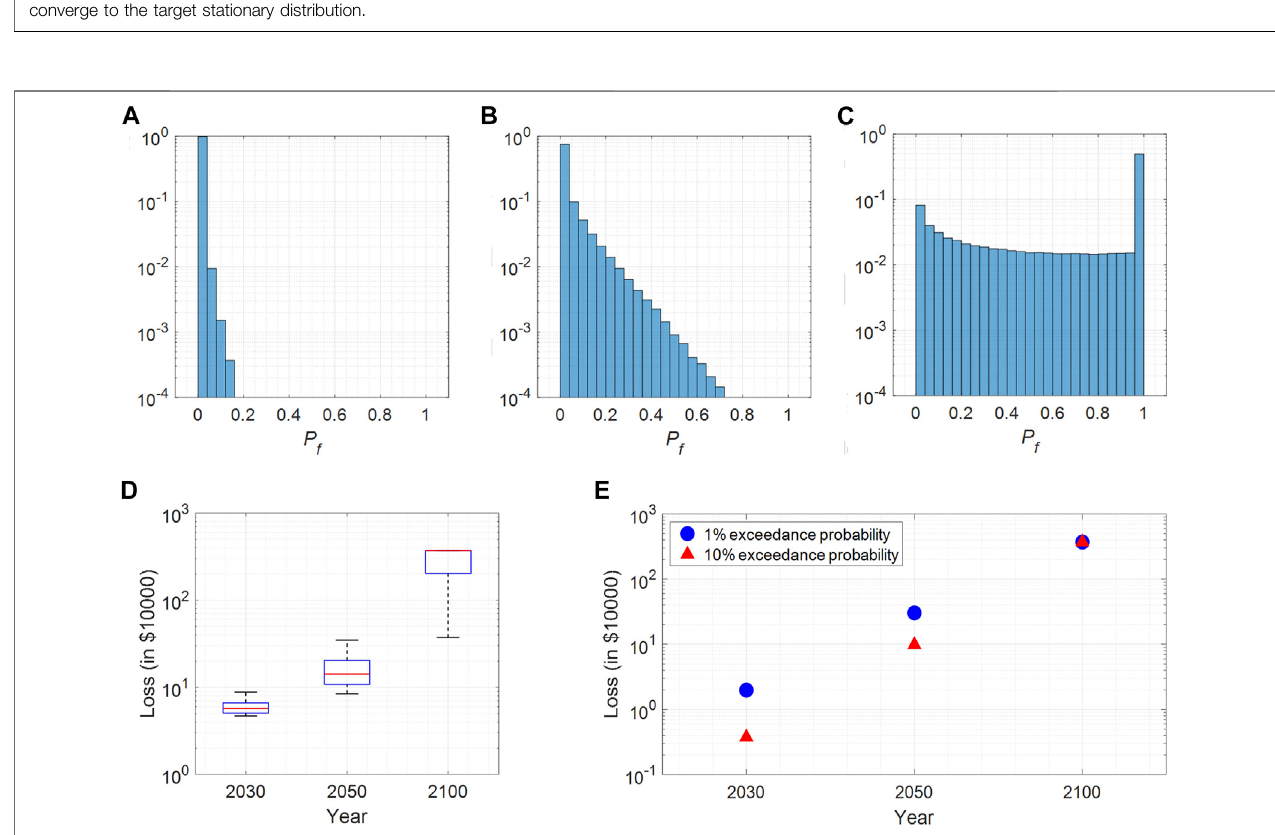
FIGURE 5| (A) The normalized histogram of failure probability of the house in the year 2030, (B) 2050, and (C) 2100, (D) the boxplot of the conditional distribution ofloss giventhe probability offailure ismore than 10%. Theblue box limits the25 and 75percentile loss,the red linedenotes themedian loss,and the twoend whiskers denote 5 and 95 percentile loss (E) the marginal loss corresponding to 1 and 10% exceedance probability for the years 2030, 2050 and 2100.